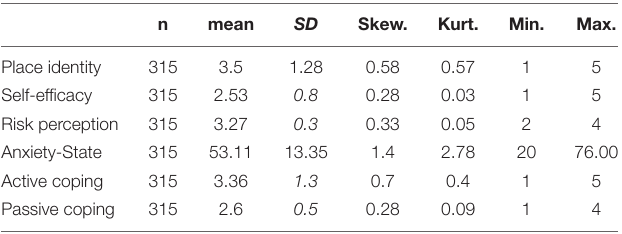
TABLE 2 | Means, standard deviation, skewness and kurtosis for each variables.